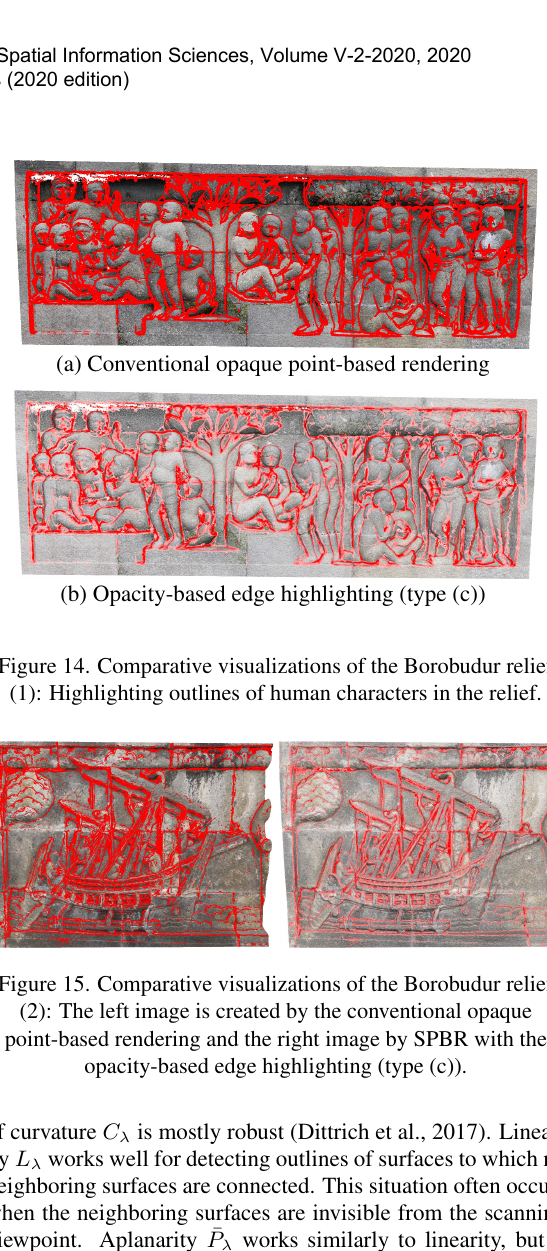
(a) Conventional opaque point-based rendering